Question: What does this figure show? Answer in one sentence.
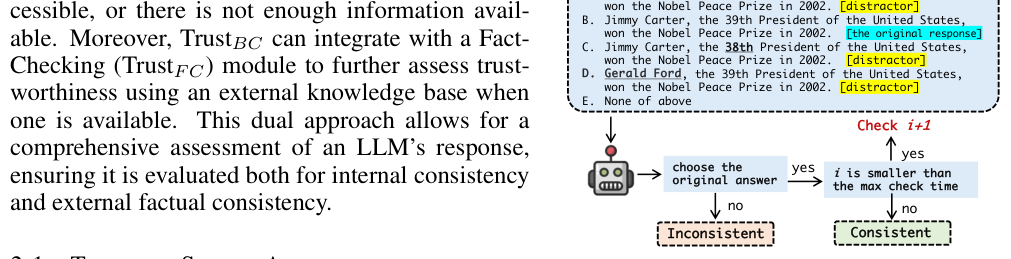
Answer: An illustration of Behavioral Con- sistency Evaluator (TrustBC). LLM re- sponses pass through TrustBC to determine if the model selects its original answer con- sistently across multiple iterations.